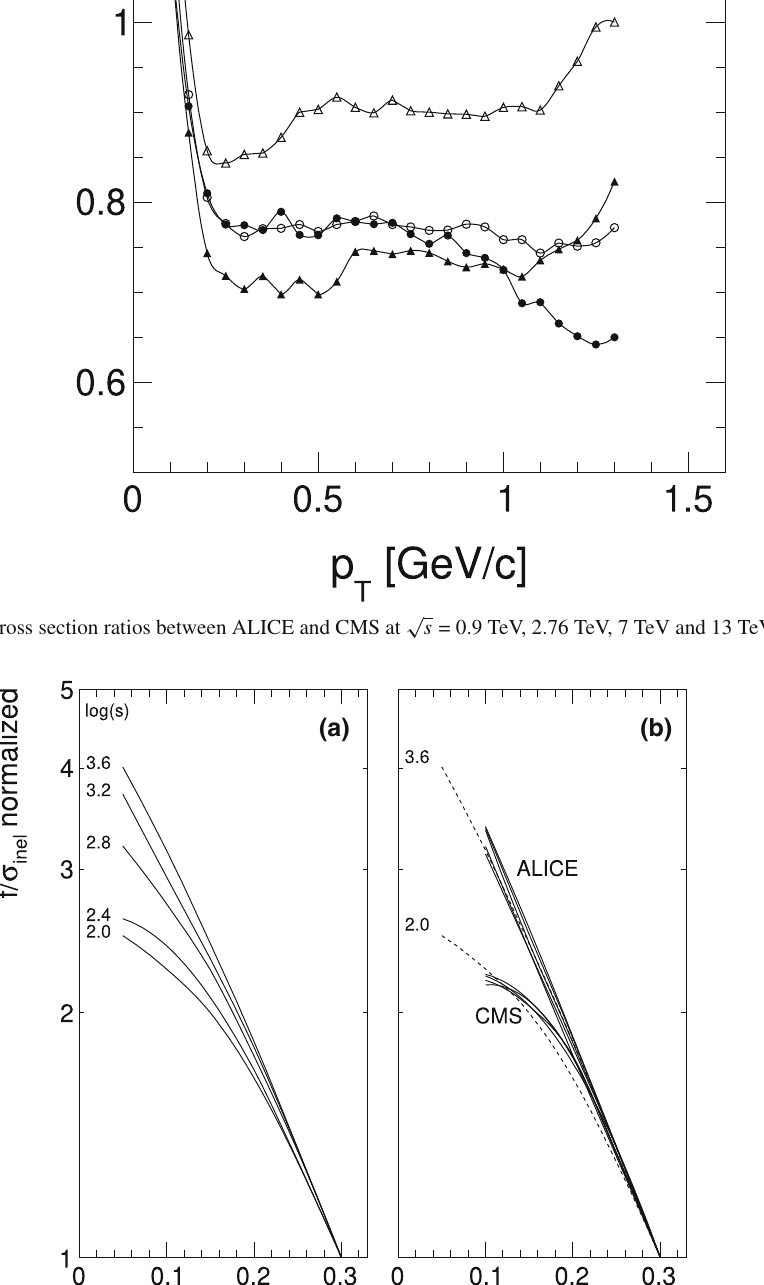
Fig. 83 a Approach of the invariant π − density towards p T = 0 GeV/c from p T = 0.3 GeV/c to clearly bring out the change of the p T dependence with interaction energy. b The same for the LHC data from ALICE [42–46] and CMS